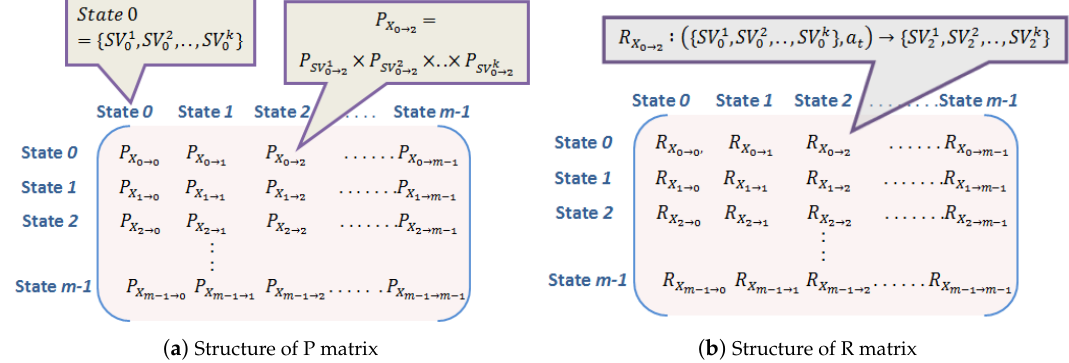
Figure 3. Structure of State transition matrix (P) and corresponding reward matrix (R) for m system states subject to an action ( a t